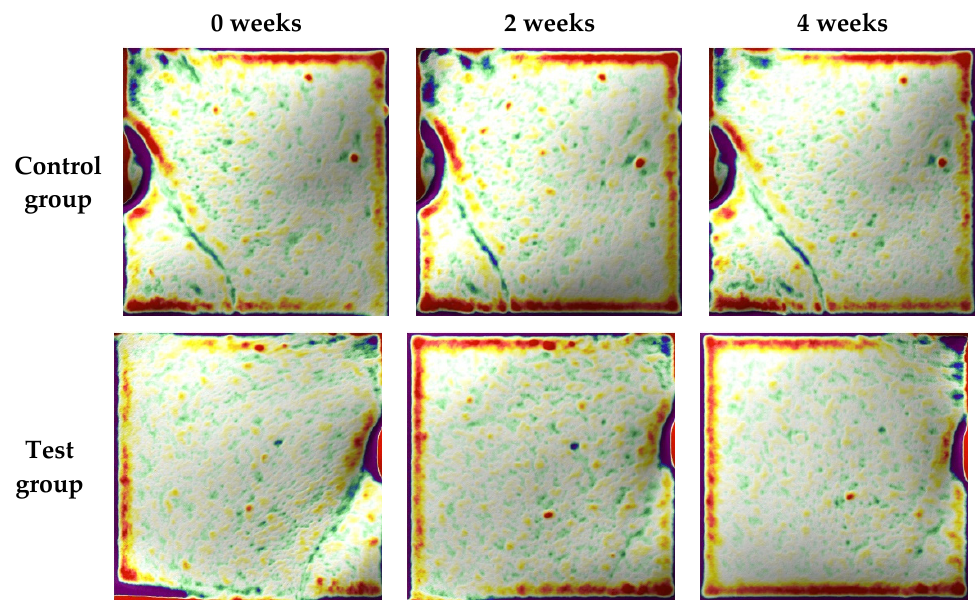
Figure 6. 3D images of wrinkles on the cheek before (0 weeks) and after (2 and 4 weeks) using the collagen peptide buccal delivery film. Table 3. The questionnaire scores after 2 and 4 weeks of using the collagen peptide buccal delivery